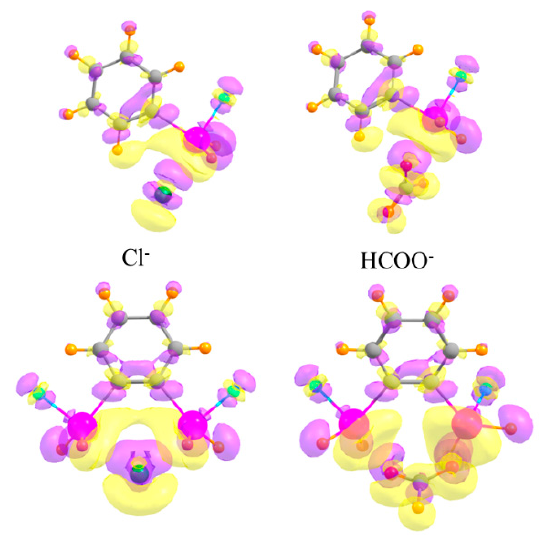
Figure 8. Density shifts caused by complexation. Upper diagrams refer to mono-SnFH 2 substituted phenyl ring, lower to ortho-disubstituted. Cl − anion on the left and HCOO − on the right. Purple and yellow regions correspond to accumulation and depletion of density, respectively, with contour shown ∆ ρ = ± 0.002 au.